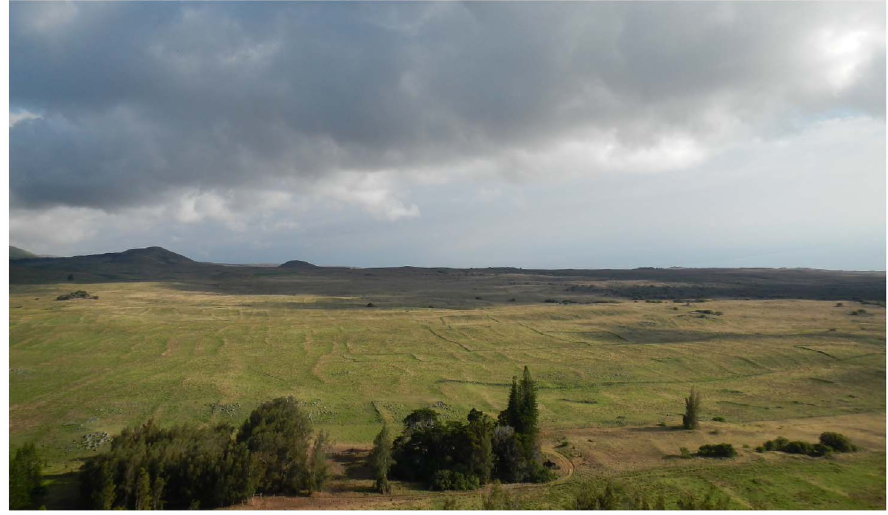
Figure 2. Photograph of a portion of the leeward Kohala field system. Note the agricultural walls running from the foreground to the background in this view looking south from Pu’u Kehena.